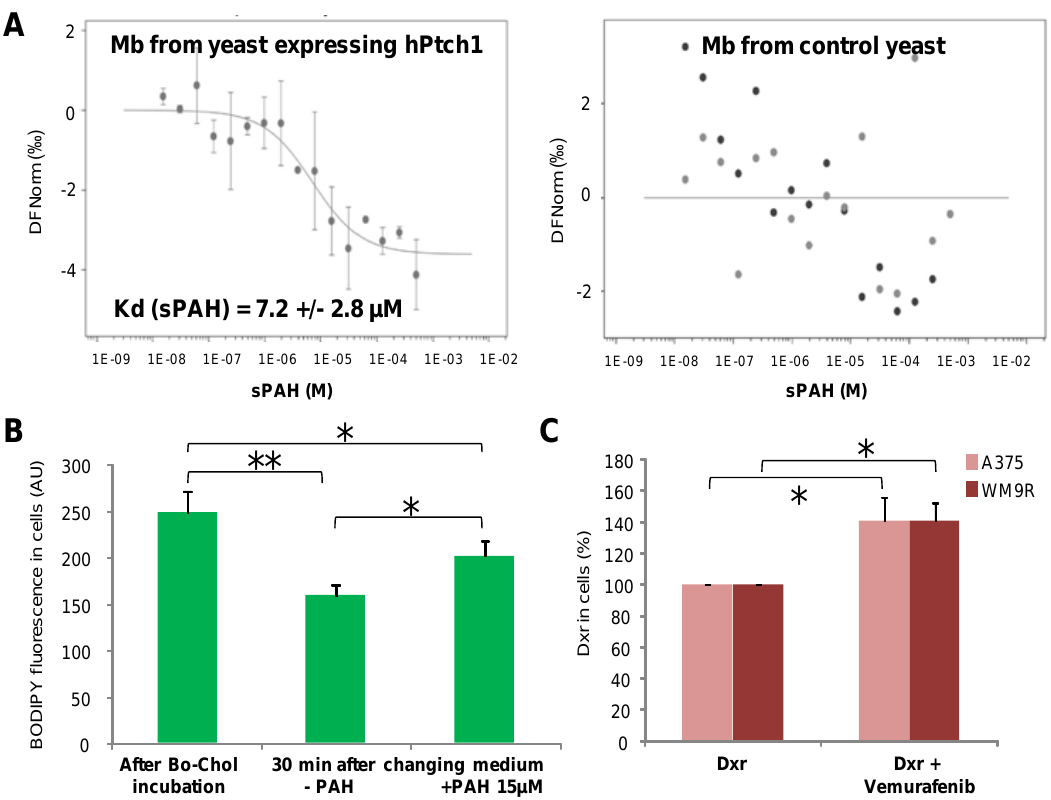
Figure 6. sPAH inhibits doxorubicin, vemurafenib and cholesterol efflux by directly binding to Ptch1. ( A ) Direct binding of sPAH to Ptch1. Membranes from yeast expressing hPtch1 or hSmoothened proteins labeled with tris-NTA-NT647 fluorescent probe were incubated with sPAH and analyzed by microscale thermophoresis (MST). Kd reported is the mean of the Kd values determined in 3 independent experiments. ( B ) sPAH inhibits BODIPY-cholesterol efflux. A375 cells were seeded on coverslips and incubated with BODIPY-cholesterol (Bo-chol) for 2 h. Three